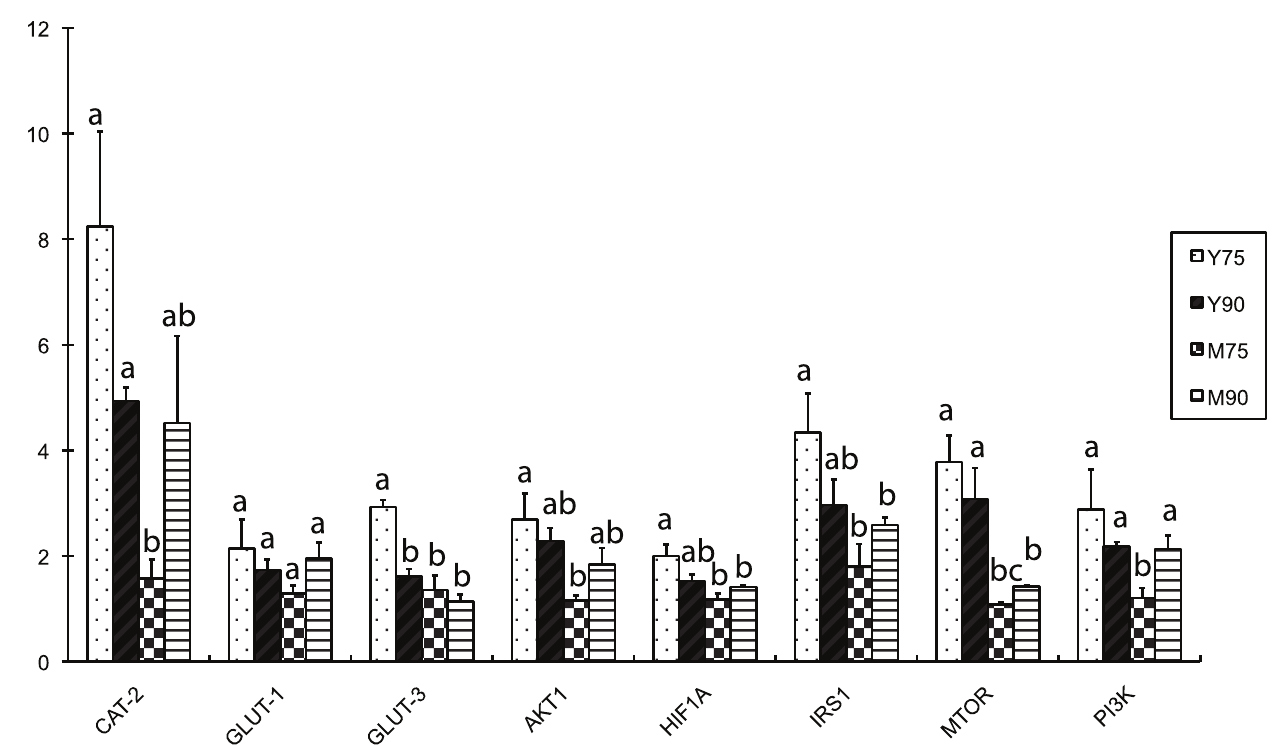
Figure 7. qPCR was used to investigate the mRNA profile of genes in the PI3K pathway in Yorkshire and Meishan pig placentas on day75 of gestation (Y75 and M75) and 90 (Y90 and M90). The expression levels were analyzed by SAS Anova test. The different superscript alphanumeric characters indicated a statistically significant difference at p , 0.05.